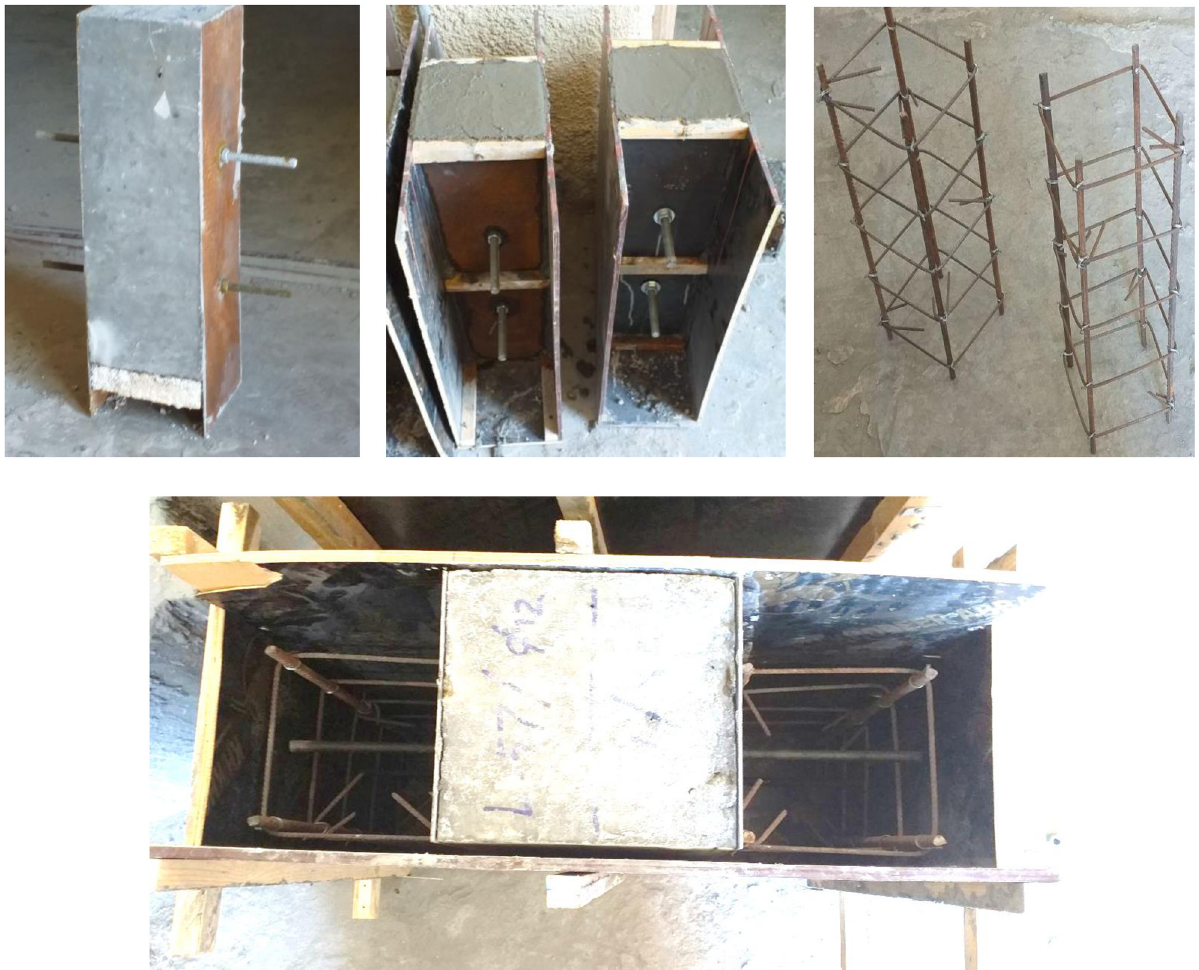
Figure 2: Fabrication process of test